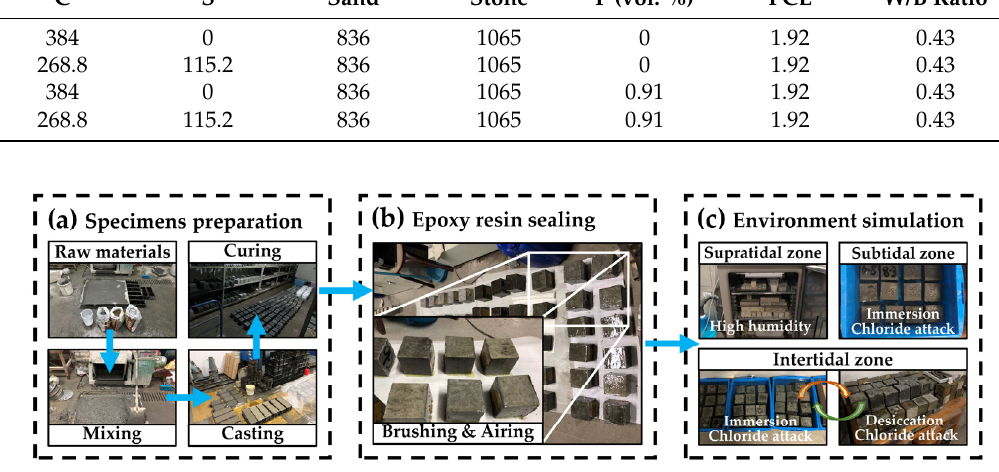
Figure 2. The preparation and service environment simulation of CBRM specimens. Table 2. The mix ratio of CBRM-Paste.